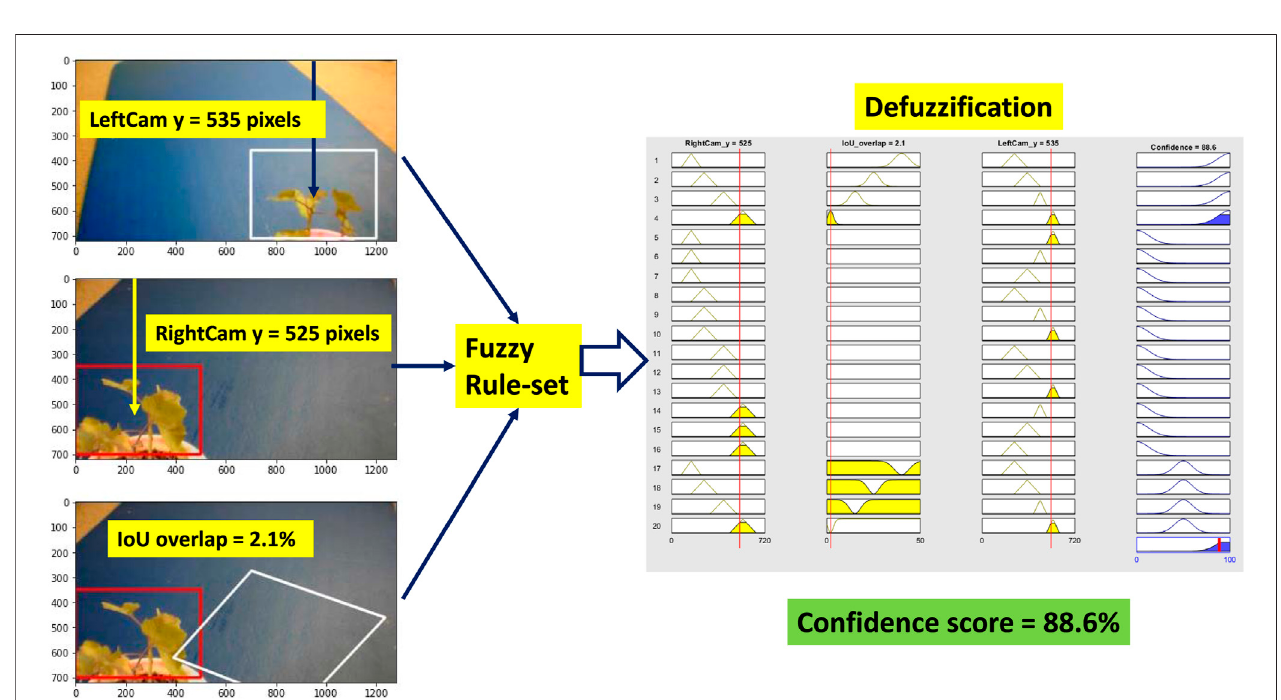
FIGURE 9 | Fuzzy con fi dence score measurement (high con fi dence). Left-hand side images show the position of detected BB and IoU overlap. Then the position value of the BB and IoU overlap goes into the fuzzy rules de fi ned in Table 3 . After the defuzzi fi cation step, we receive the con fi dence score of the detection.